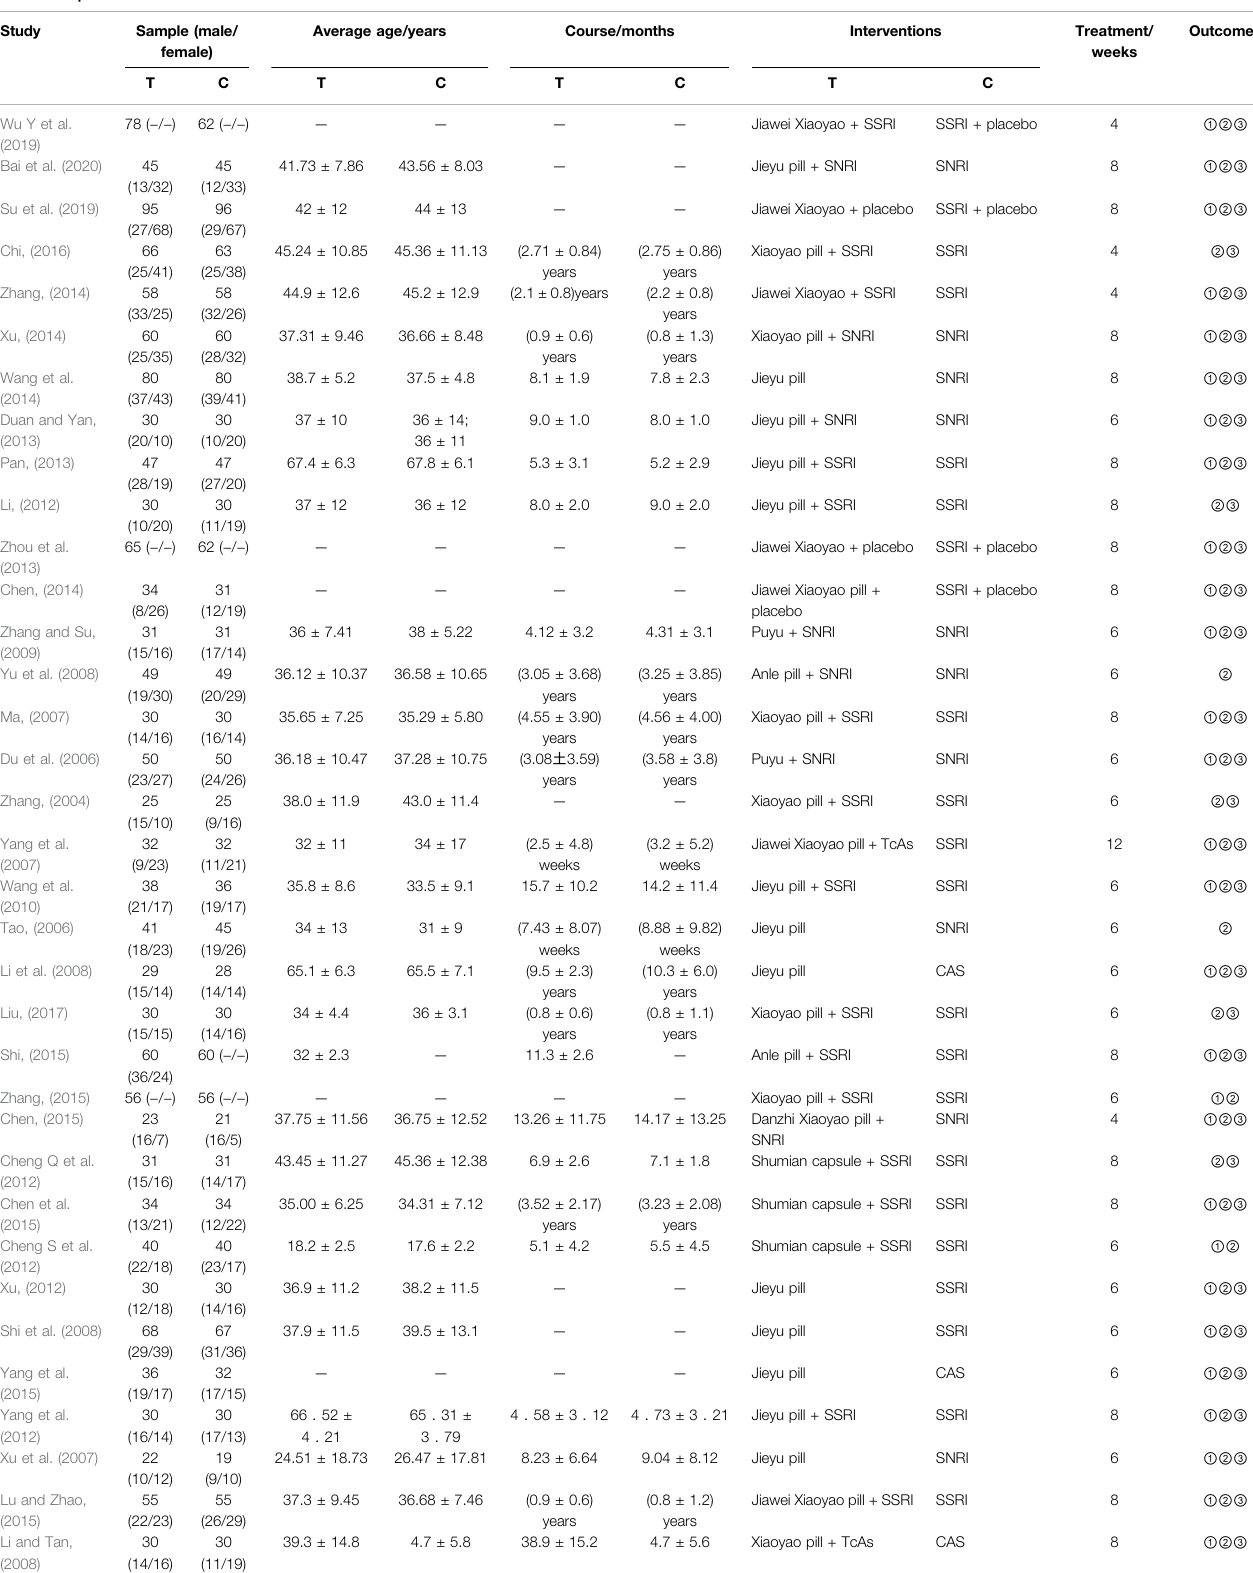
TABLE 1 | Basic information of included studies.